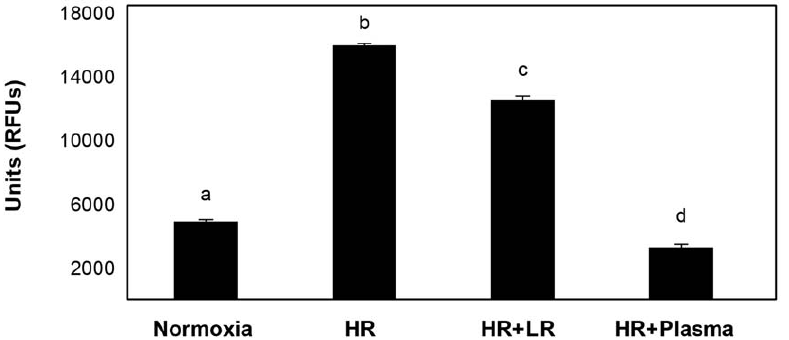
Figure 3. Endothelial cell permeability is decreased by FFP in an in vitro model of endothelial injury. HUVEC’s were stimulated with IL- 1 b and subjected to hypoxia for four hours followed by rexoygenation and incubation for an additional four hours in media alone (hypoxia/ reoxygenation, HR), 5% lactated Ringers (LR), or 5% FFP, and compared to normoxia. In vitro permeability was assessed by fluoresceine-isothiocyanate [FITC] labeled dextran transport. Permeability was significantly increased by HR compared to normoxia, lessened by LR, but FFP decreased permeability to below that of normoxia. Results are presented as means 6 SEM, n=6/group. Means notated with letters indicate statistical differences between